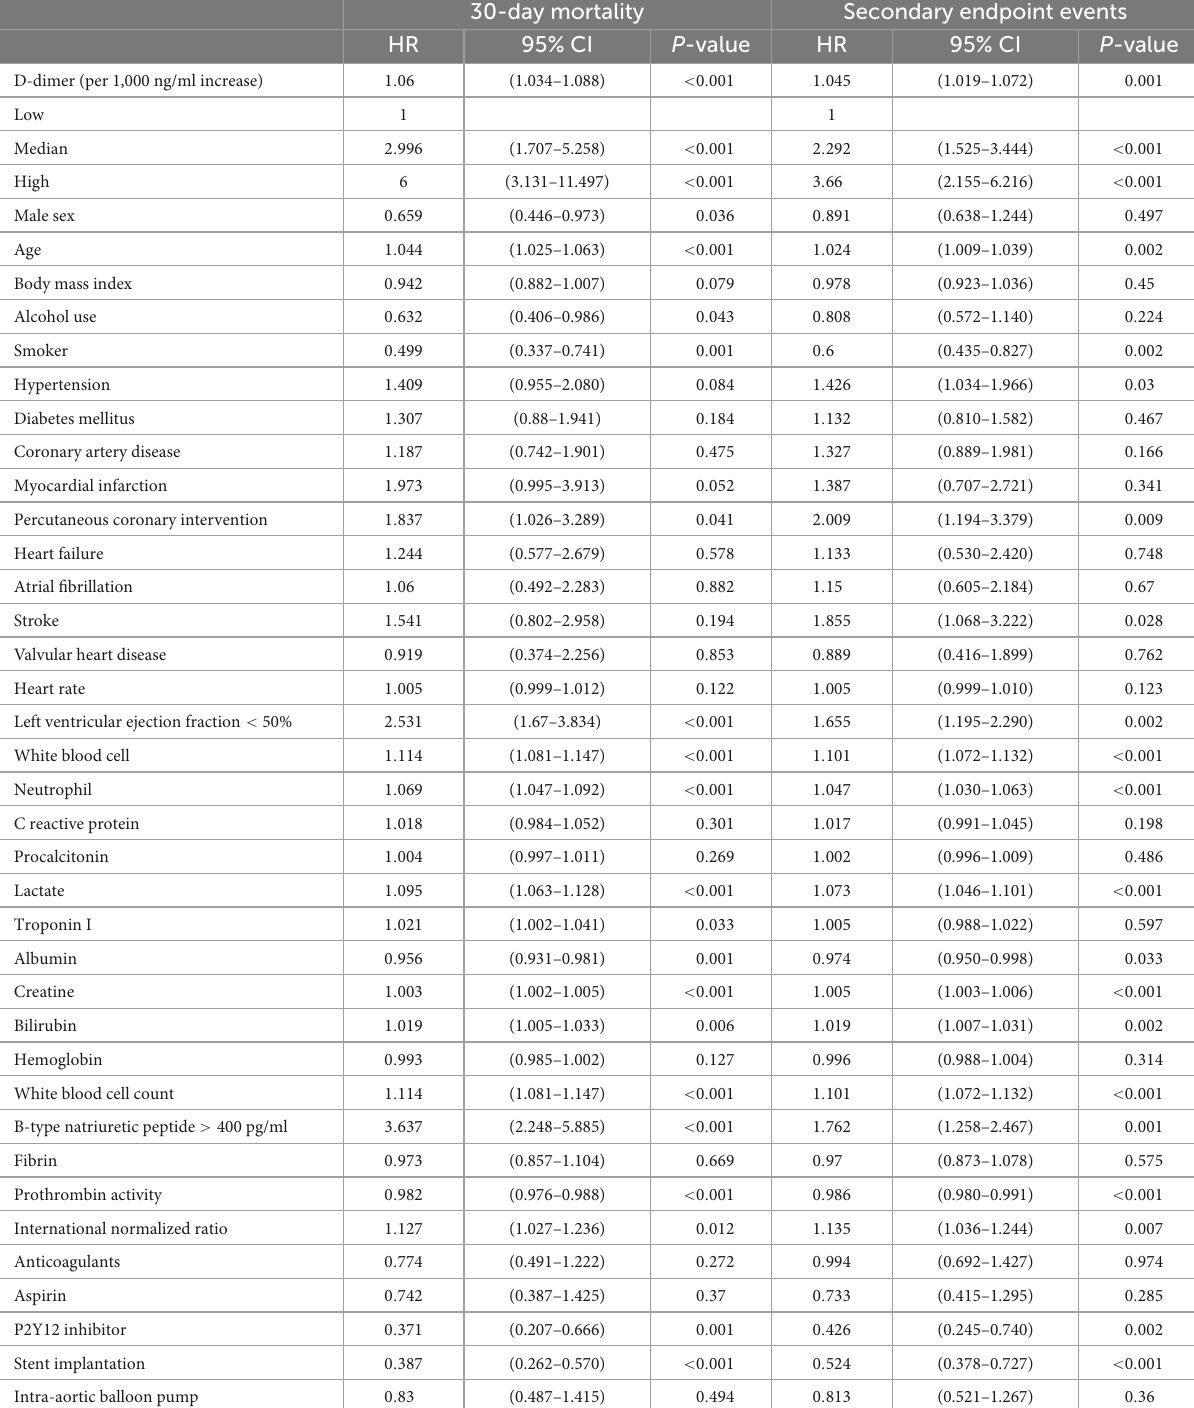
TABLE 3 Univariable Cox regression